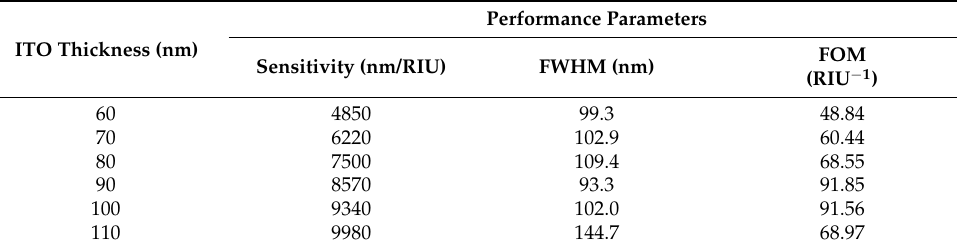
Table 2. Calculation of performance parameters corresponding to the first LMR curve for various thicknesses of the ITO film coated over the U-shaped optical fiber. Performance Parameters ITO Thickness (nm)